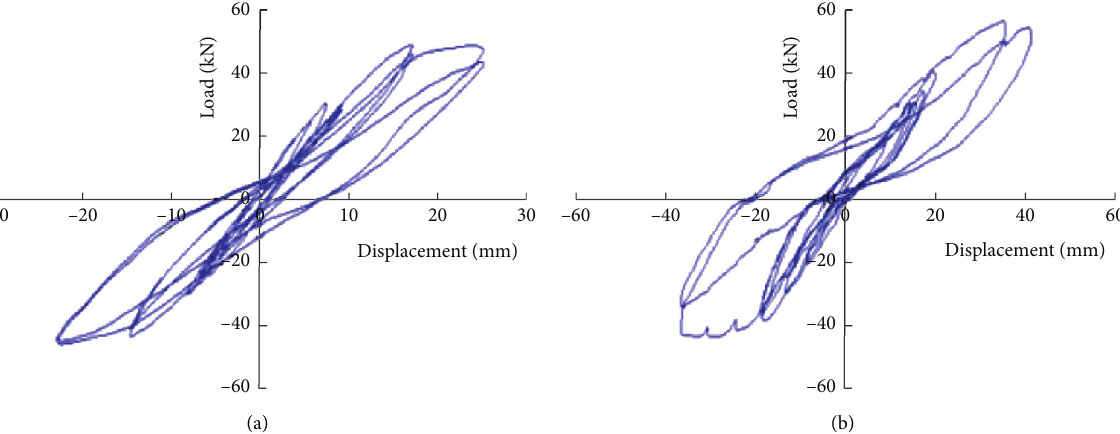
Figure 6: Comparison of the hysteretic curves of model 2 (experimental results): (a) before reinforcement; (b) after reinforcement.